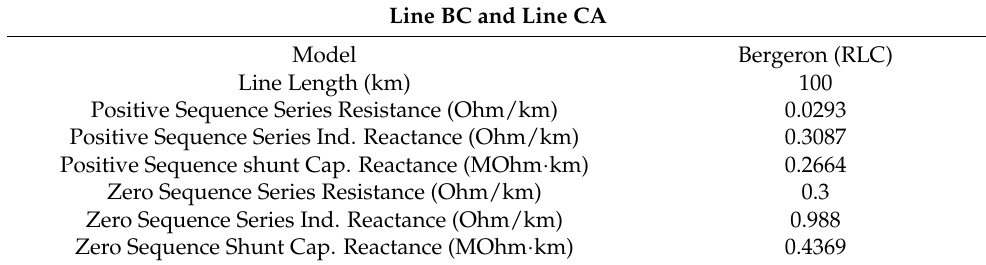
Table 12. 150 kV Transmission lines’ Data.